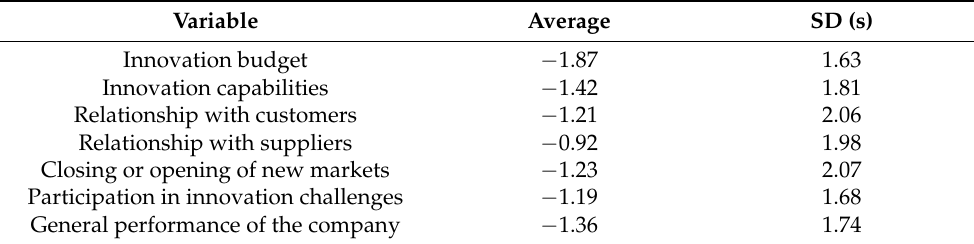
Table 8. Effects of the COVID-19 pandemic on the surveyed companies. Variable Average SD (s) Innovation budget − 1.87 1.63 Innovation capabilities − 1.42 1.81 Relationship with customers − 1.21 2.06 Relationship with suppliers − 0.92 1.98 Closing or opening of new markets − 1.23 2.07 Participation in innovation challenges − 1.19 1.68 General performance of the company − 1.36